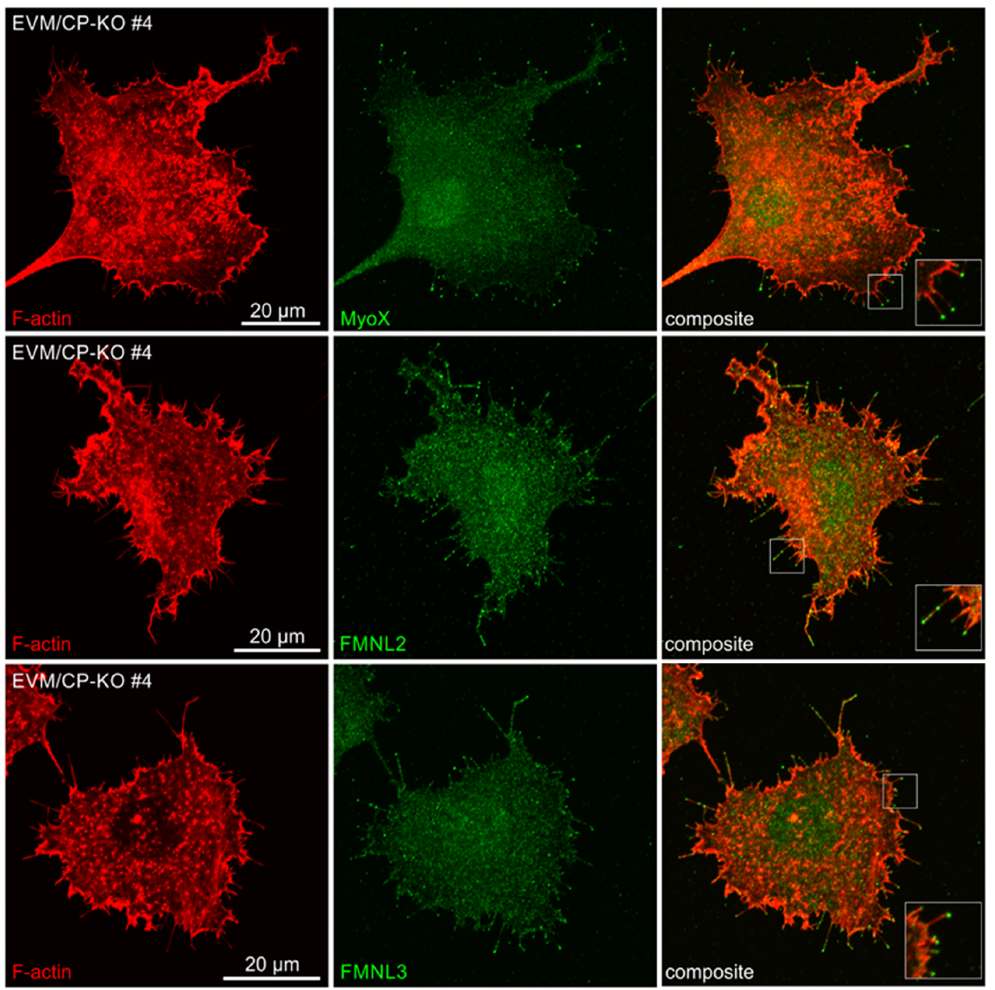
Figure 7. Endogenous MyoX, FMNL2 and FMNL3 accumulate at the tips of filopodia in EVM/CP-KO cells. Representative EVM/CP-KO cells stained for MyoX and F-actin (upper panel), for FMNL2 and F-actin (middle panel) and for FMNL3 and F-actin (lower panel). Insets, enlarged images of boxed regions.